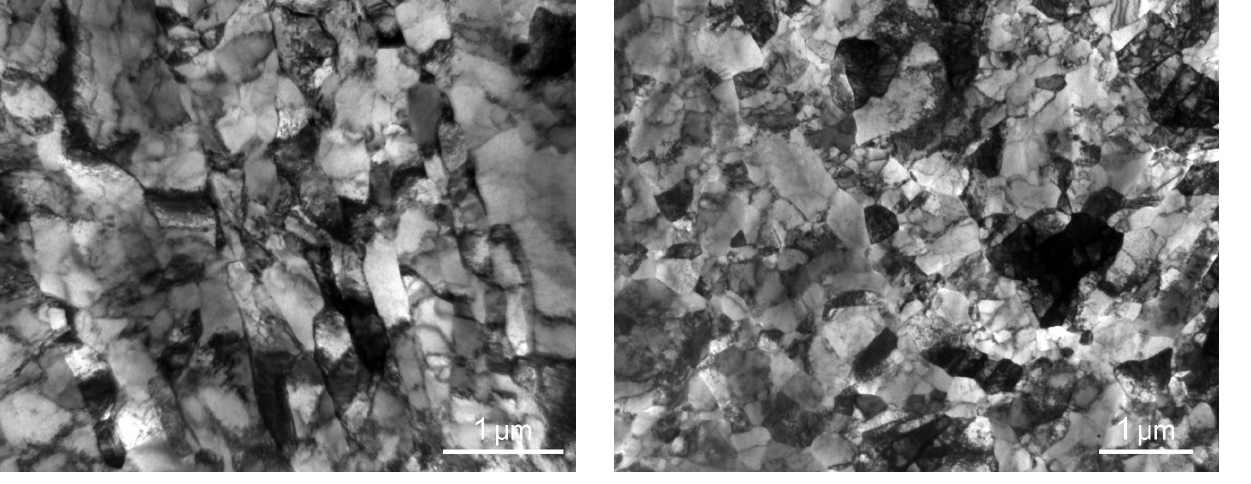
Figure 2a: Microstructure of Cu after ECAP as observed in TEM, longitudinal section.